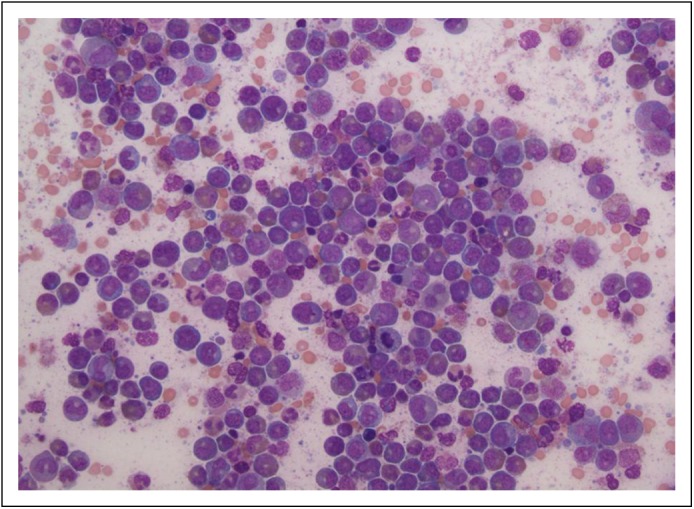
– Bone marrow aspirate with a marked increase in eosinophils and
eosinophilic precursors, admixed with approximately 8% blasts.